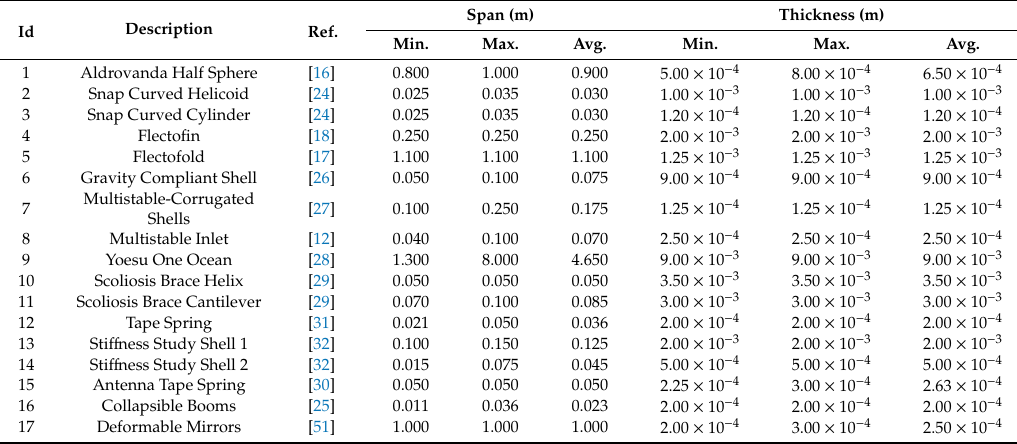
Table A4. Dimensions of the compliant engineered thin shells included in the study